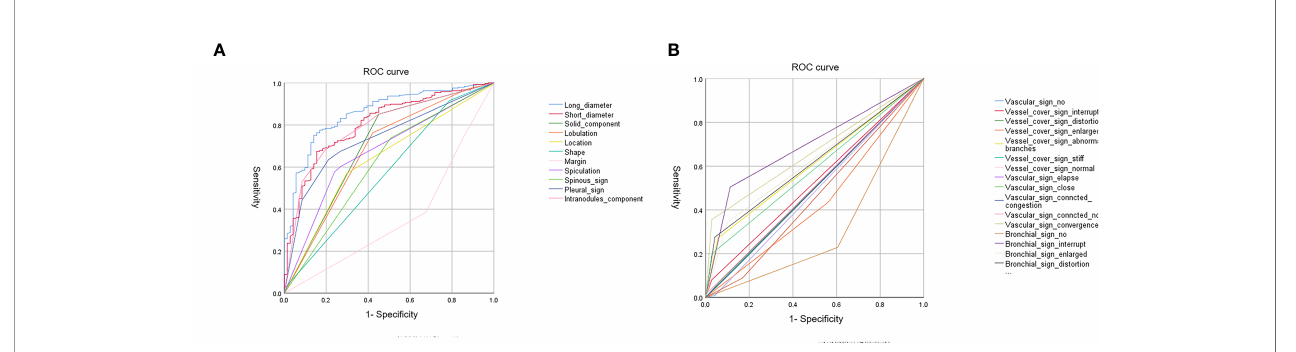
FIGURE 3 | (A, B) ROC curves for CT fi